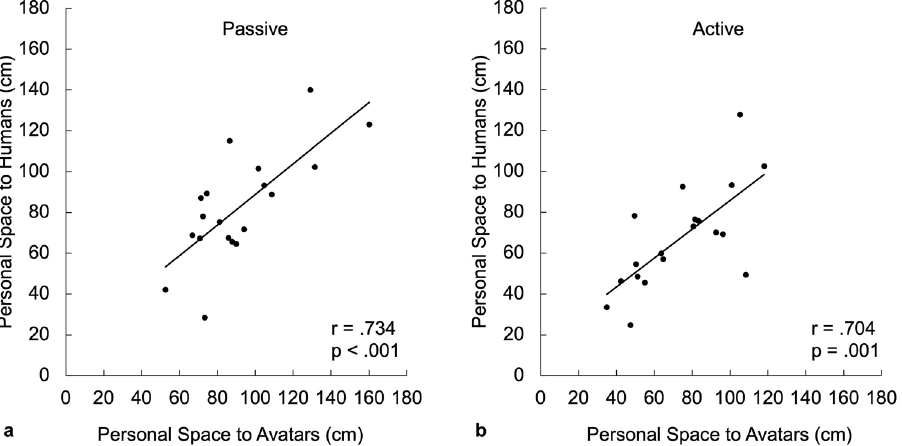
Figure 4. Personal space size measured to human intruders (y axis) is highly correlated with the personal space size measured to virtual intruders (x axis). Each dot represents the average personal space size measured in each subject using the Stop Distance Procedure (SDP) (n = 19). Panel ( a ) shows the correlation in the passive SDP measurements, and Panel ( b ) shows the correlation in the active SDP